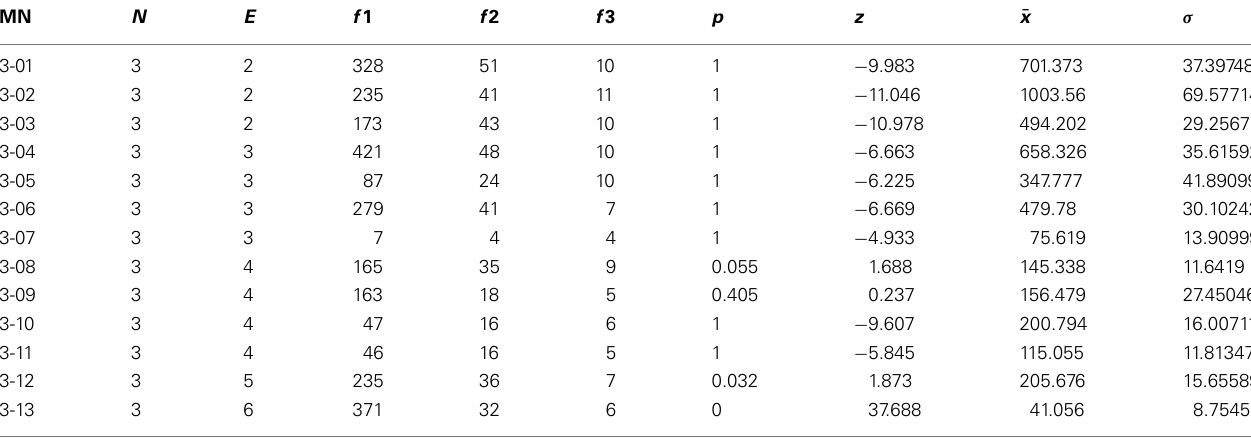
Table 3 |All 13 3-node motifs and resampling calculations based on 1000 rewiring randomizations of 49 regions and 464